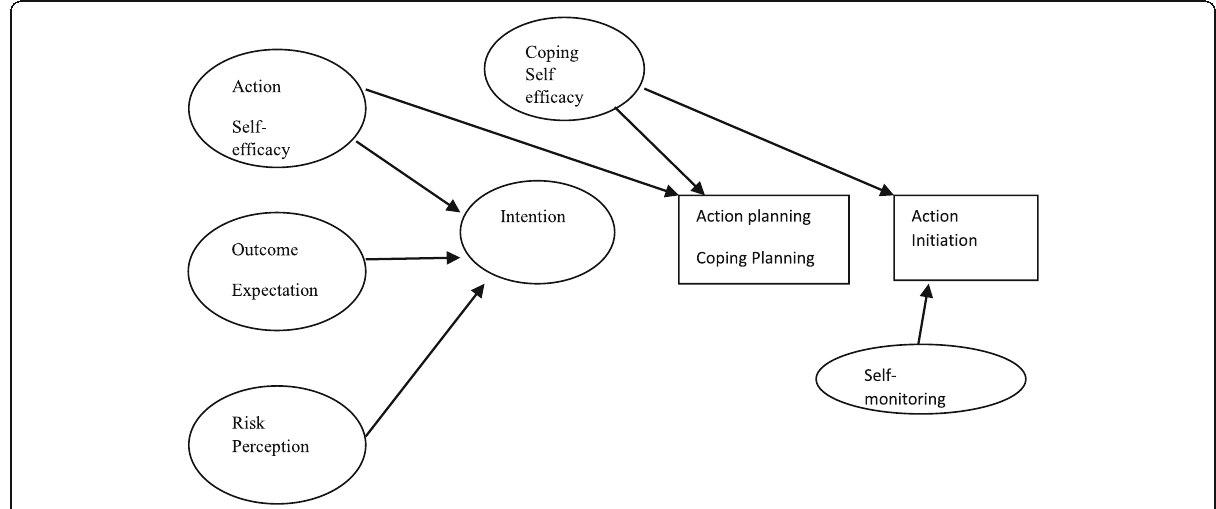
Fig. 1 The default relationship between the variables, based on the health action process approach